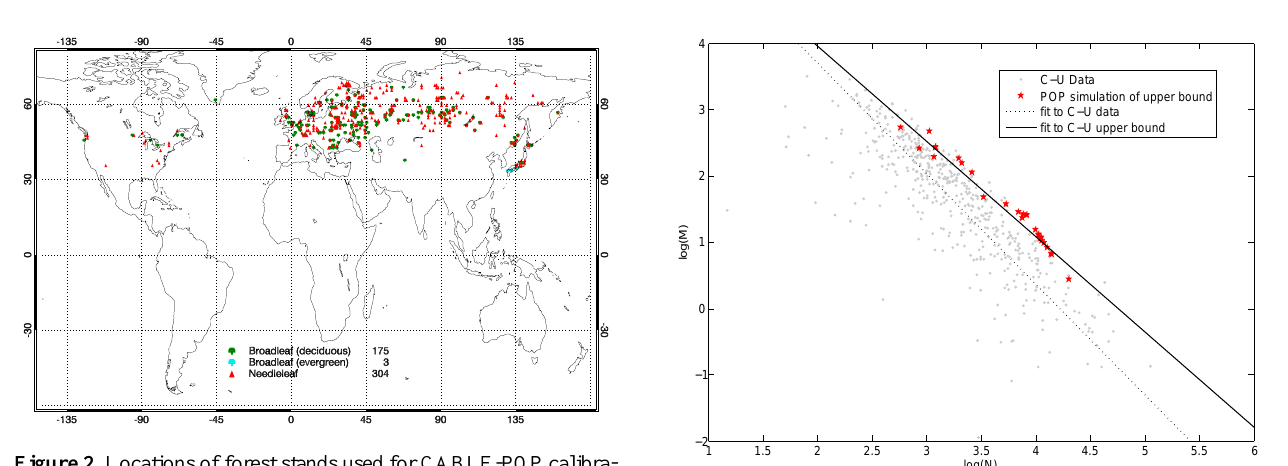
Figure 2. Locations of forest stands used for CABLE-POP calibra- tion and evaluation.